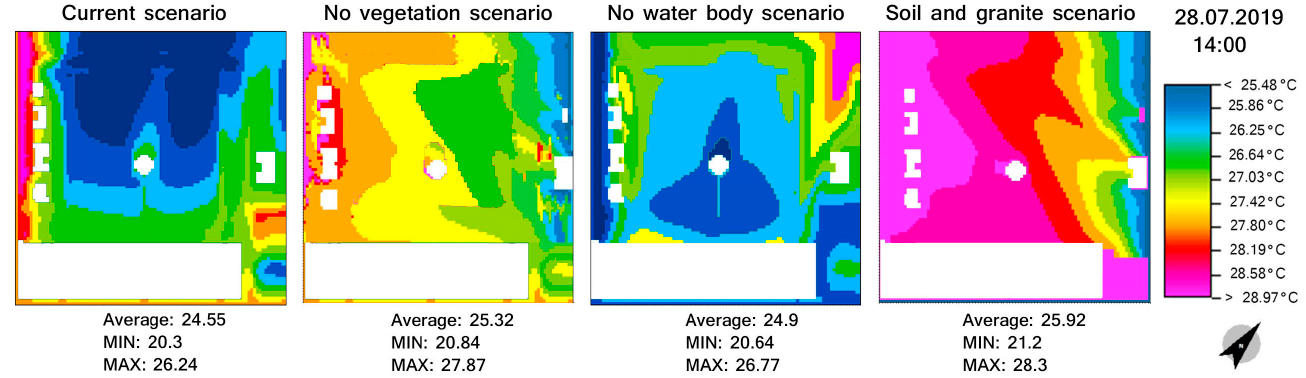
Figure 6. Simulated air temperature values at a height of 1.5 m agl averaged for all scenarios at an